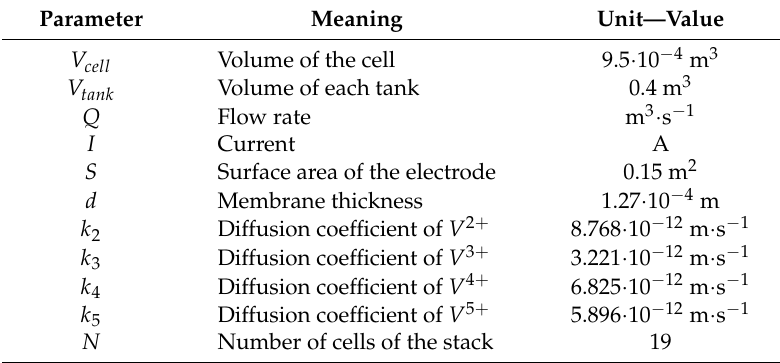
Table 2. Parameters of the electrochemical model